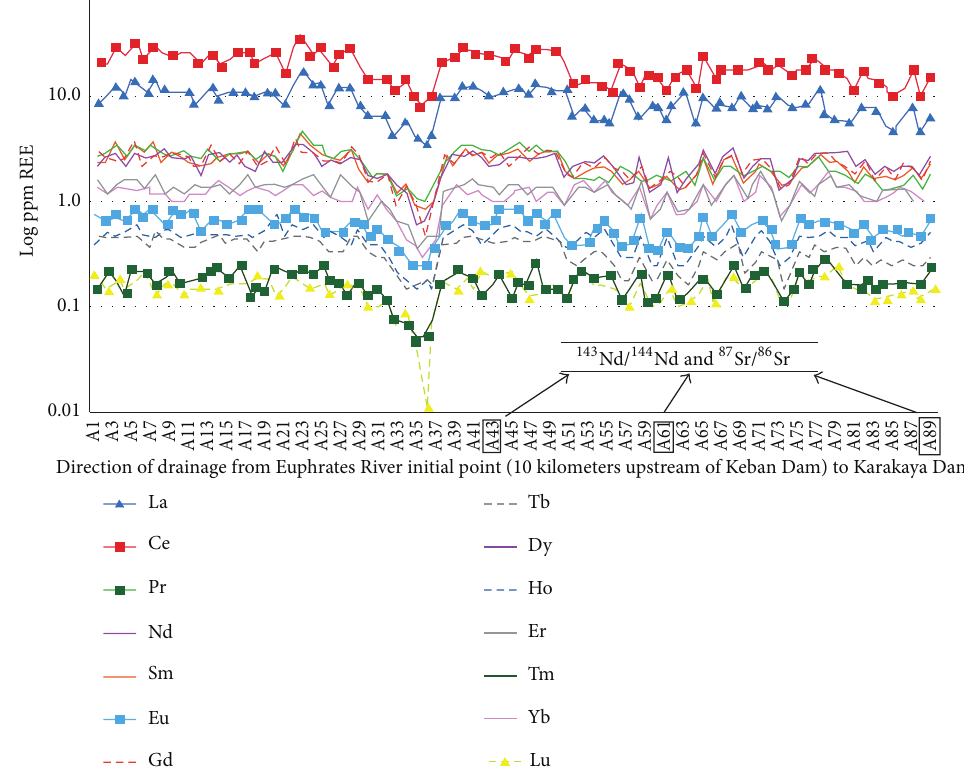
Figure 2: Distribution of REE and the determined sample sites (A43, A61, and A89) for 87 Sr/ 86 Sr and 143 Nd/ 144 Nd isotopic analysis from the Euphrates River